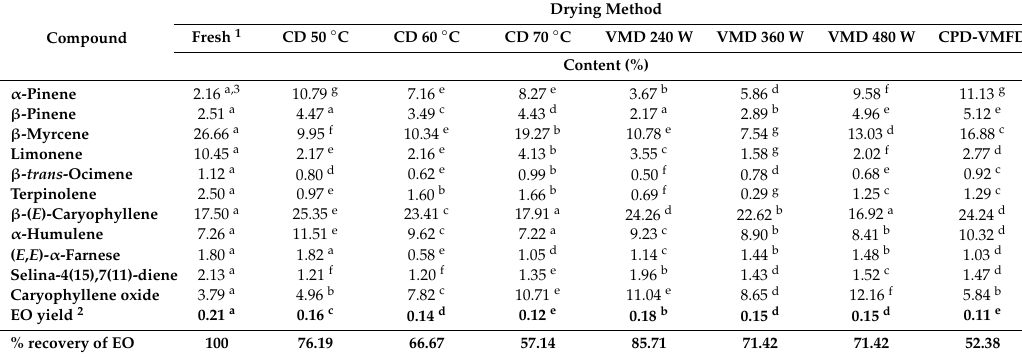
Table 4. Comparison of changes in volatile composition of fresh and dried hemp flowers.